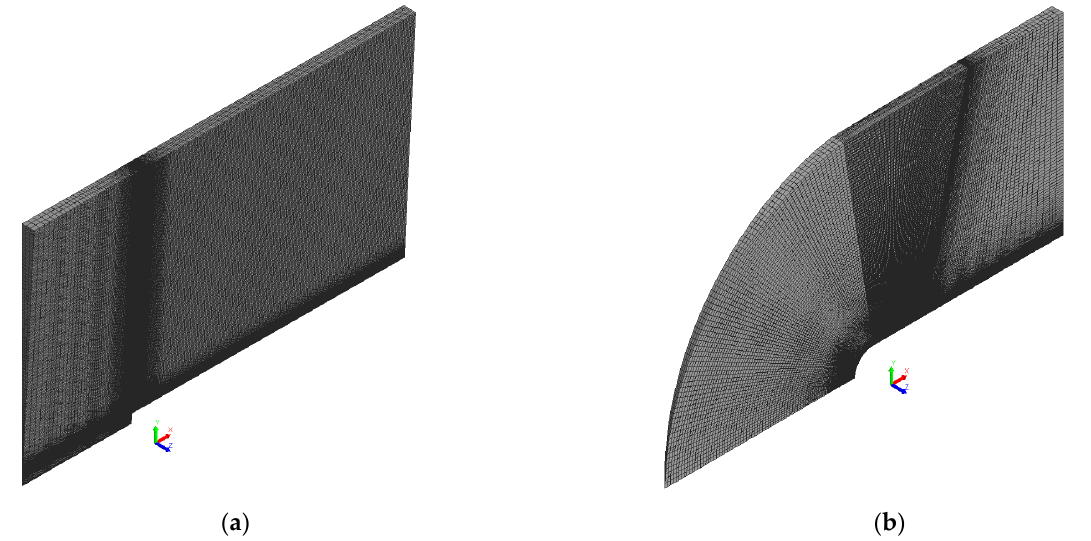
Figure 1. A mesh model: ( a ) a cylinder with a plane end; ( b ) a cylinder with a semispherical end.